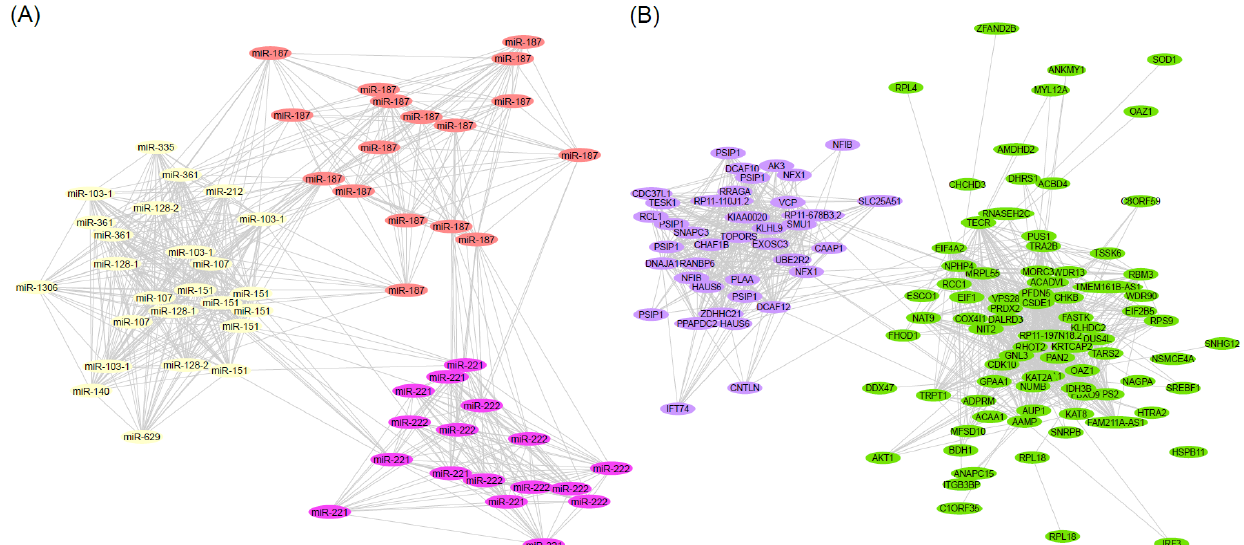
Figure 3. Weighted correlation network analysis of mRNA and miRNA transcripts. ( A ) The miRNA modules lightcoral , plum , and ivory are visualized in their respective colors. Each node represents one miRNA isoform, and each edge represents a connection or coexpression. The distance between nodes is the connection weight, where more similarly expressed transcripts are plotted closer. ( B ) The mRNA modules lavenderblush3 and darkolivegreen are visualized in their respective colors. Each node represents a transcript, and each edge represents a connection or coexpression. The distance between nodes is the connection weight, where more similar transcripts are plotted closer.